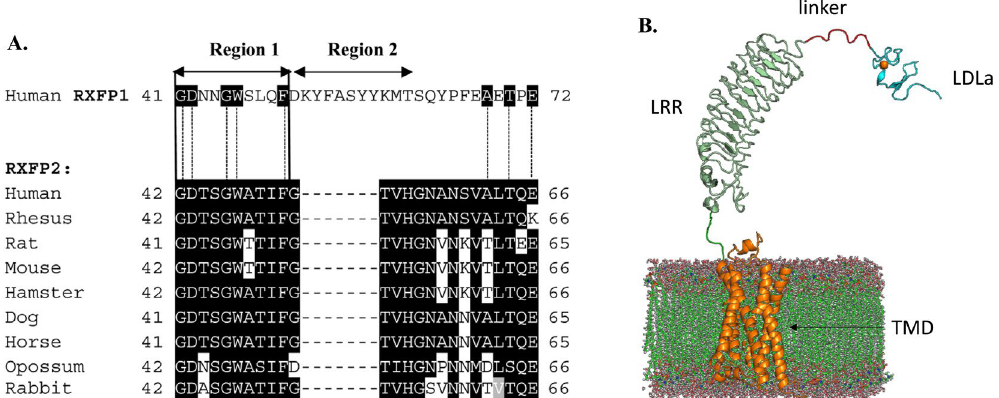
Figure 1. ( A ) Sequence alignment of the 25-residue RXFP2 linker from mammalian species shown with the human RXFP1 linker, which is 32 residues long. Residues GDxxGWxxxF comprise region 1, thought to be important for activation, and region 2 is the proposed relaxin-binding site. Region 2 is absent from the RXFP2 linker. Species shown are human, rhesus ( Macaca mulatta ), rat ( Rattus norvegicus ), mouse ( Mus musculus ), chinese hamster ( Cricetulus griseus ), dog ( Canis lupus ), horse ( Equus caballus ), opossum ( Monodelphis domestica ) and rabbit ( Oryctolagus cuniculus ). Sequences are from UniprotKB. ( B ) Putative structure of RXFP2 showing the distinct protein domains, the transmembrane domain (TMD) shown in orange, leucine-rich repeats (LRR) in green, linker in purple and LDLa module in blue. Calcium ion is an orange